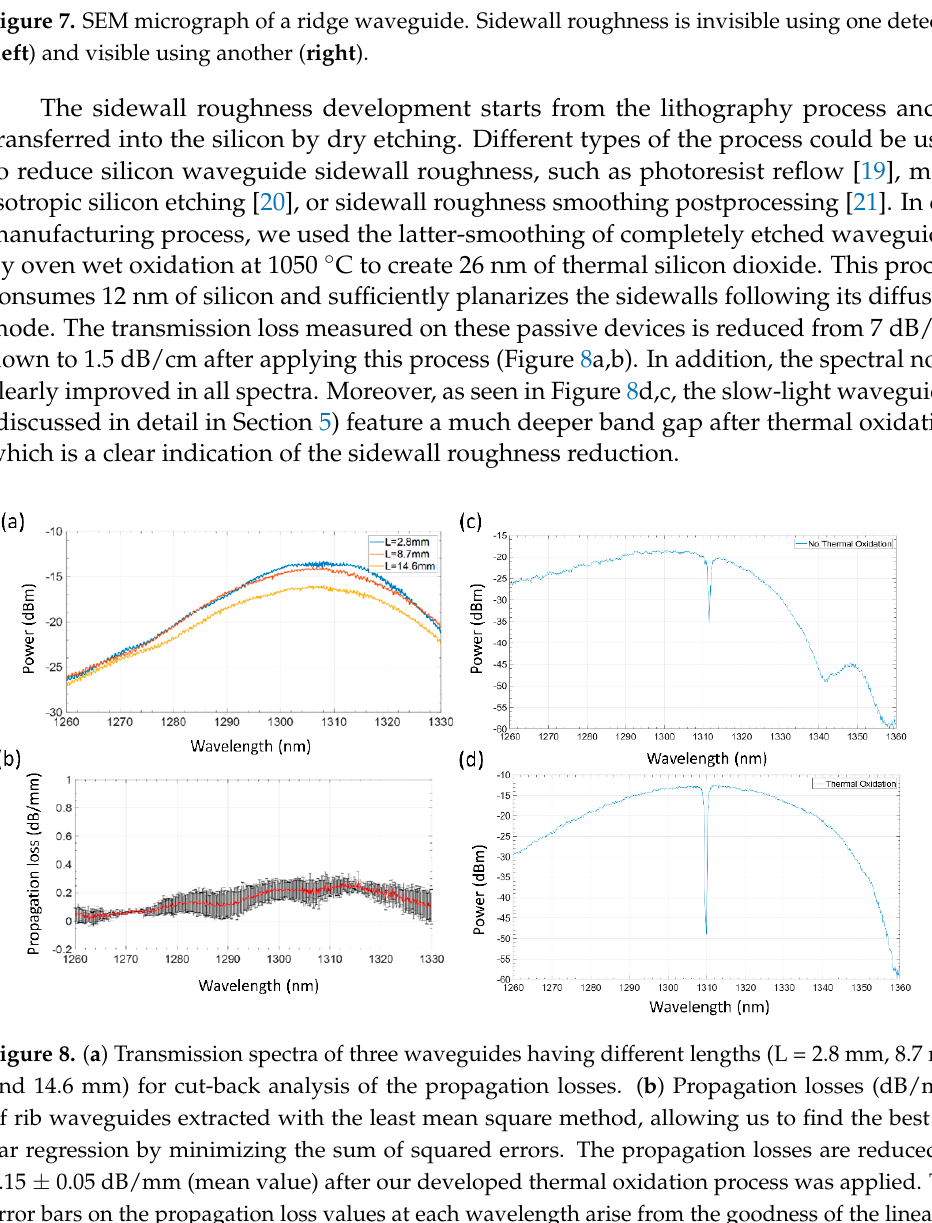
Figure 7. SEM micrograph of a ridge waveguide. Sidewall roughness is invisible using one detector (left) and visible using another (right).